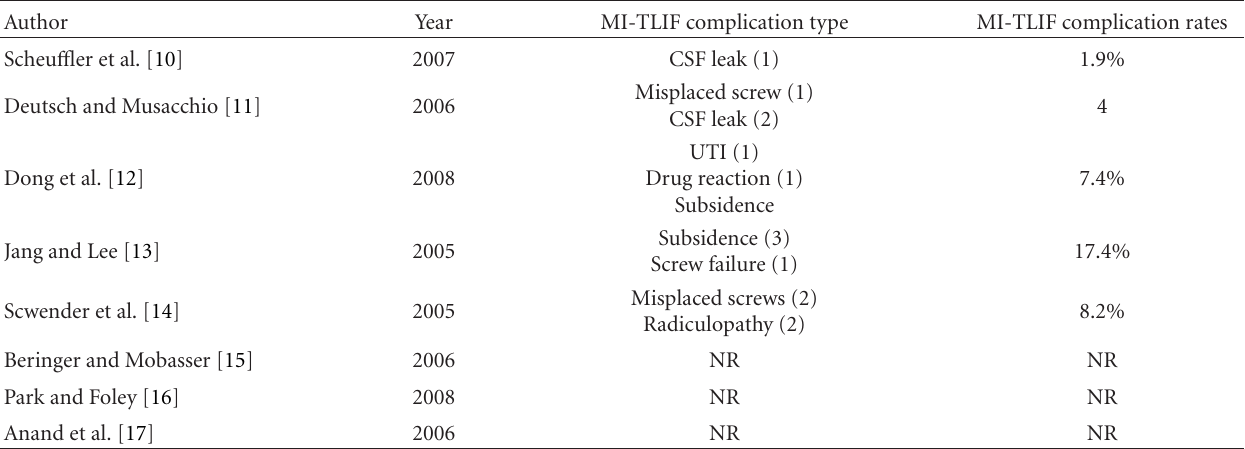
Table 5: MI-TLIF complication types and complication